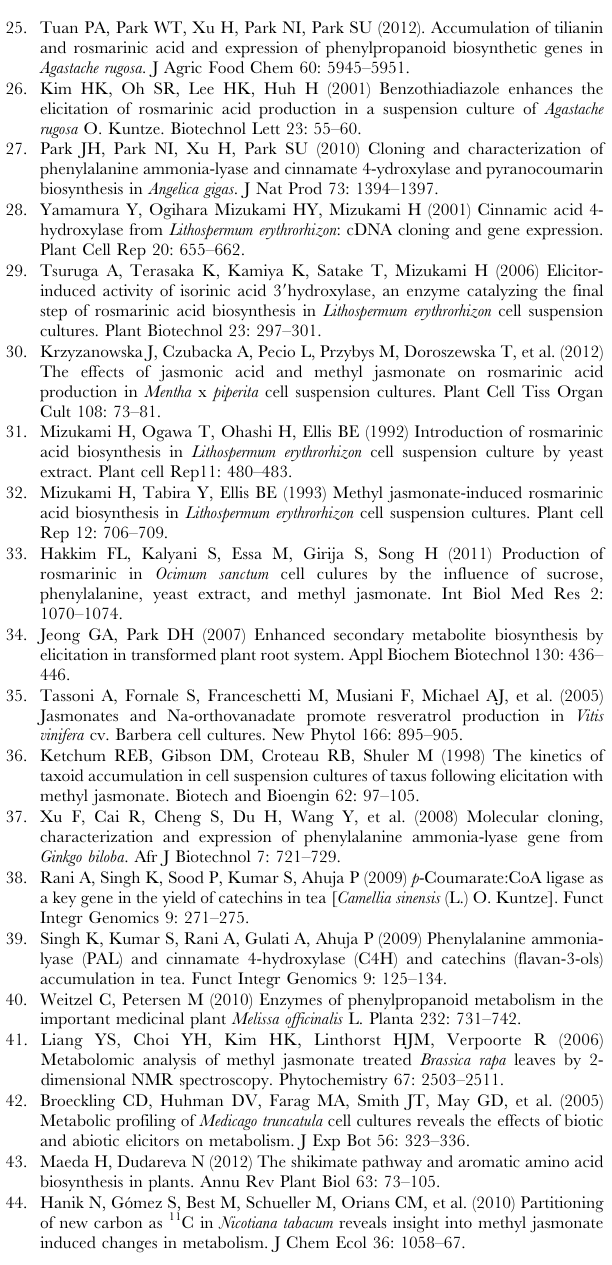
Table S1 The detected chromatographic and spectro- metric data of the 45 identified compounds analyzed by